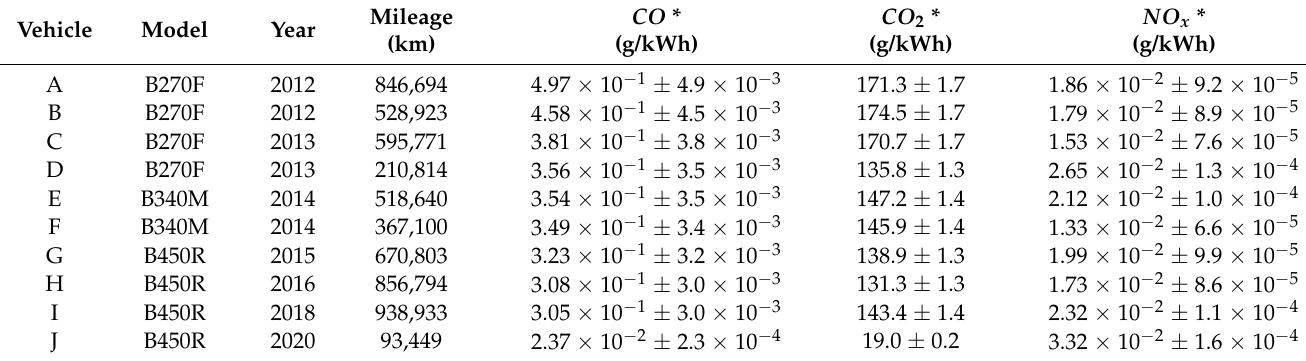
Table 5. Concentration of fugitive gases analyzed in the laboratory. Values converted to (g/kWh).